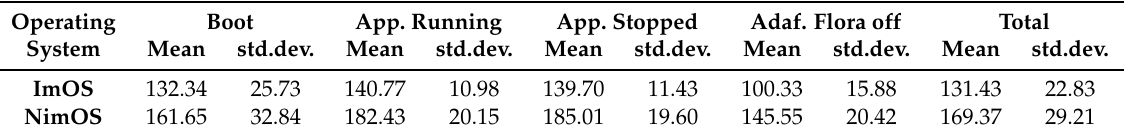
Table 6. Improved operating system (ImOS) vs. not improved operating system (NimOS): current (mAh) measurement overview.